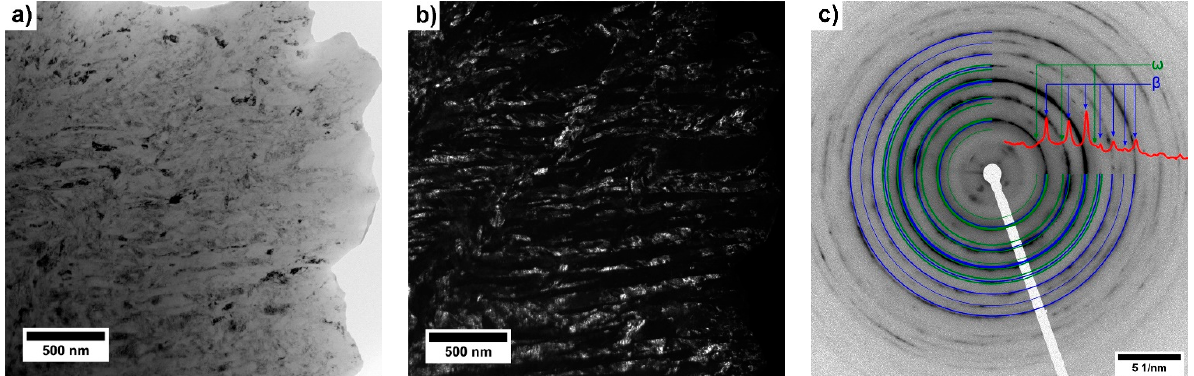
Figure 2. ( a ) TEM bright field image, ( b ) TEM dark field image and ( c ) the corresponding SAED pattern of the RS material. The dark field image was obtained from an arbitrarily selected part of the diffraction rings shown in Figure 2c.